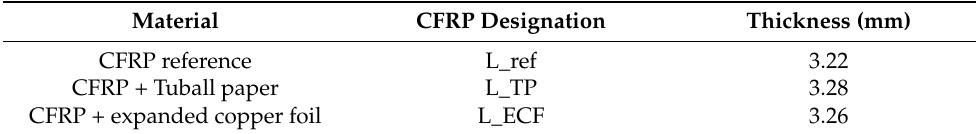
Table 3. Characteristics of composite panels manufactured for LS